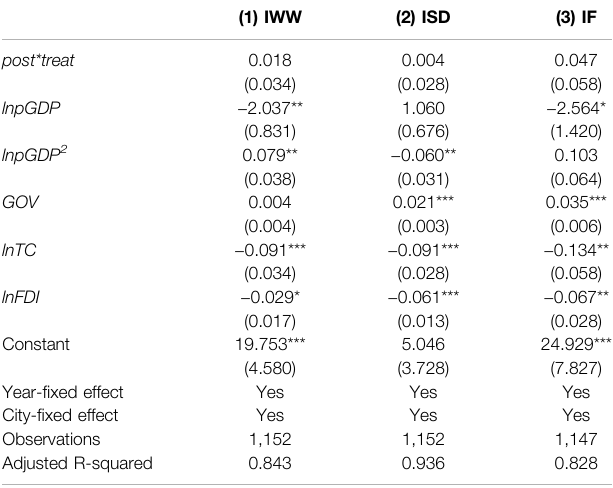
TABLE 8 | Regression results from the synergistic effect of carbon reduction and pollution